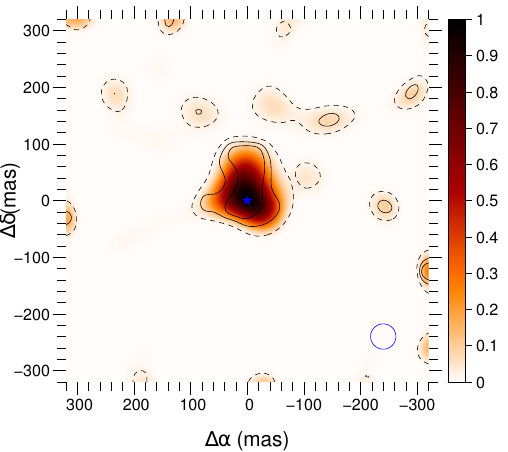
Figure 2. II Lup’s M band image reconstructed with MiRA. The flux scale has been normalized to unity, and the contours represent the 5, 3 (solid) and 1 (dash) significance levels. The resolution element is indicated by a blue circle and the position of the central star by a blue